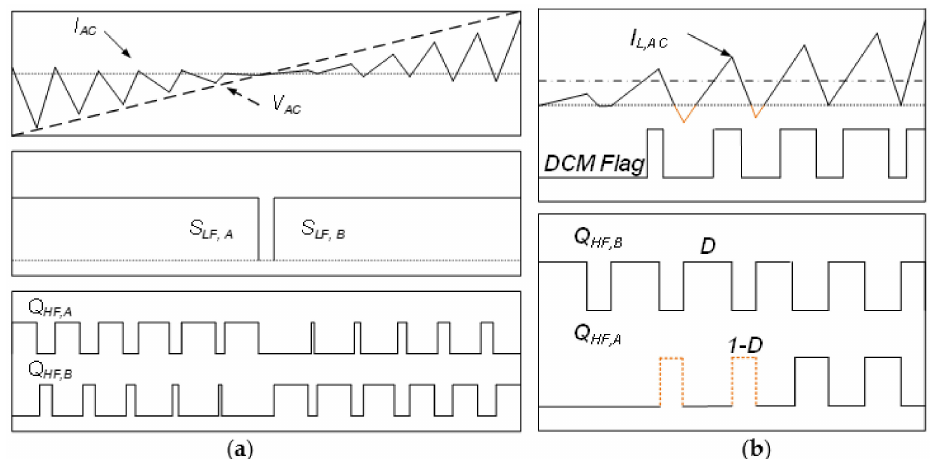
Figure 3. Key waveforms of the totem-pole PFC. ( a ) waveforms of basic operation and ( b ) detail waveforms of synchronous pulse width modulation (PWM) at positive